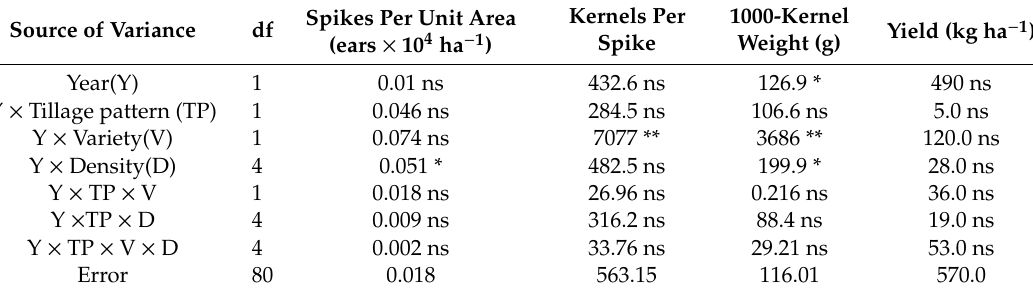
Table 1. Variance analysis of yield and yield composition between